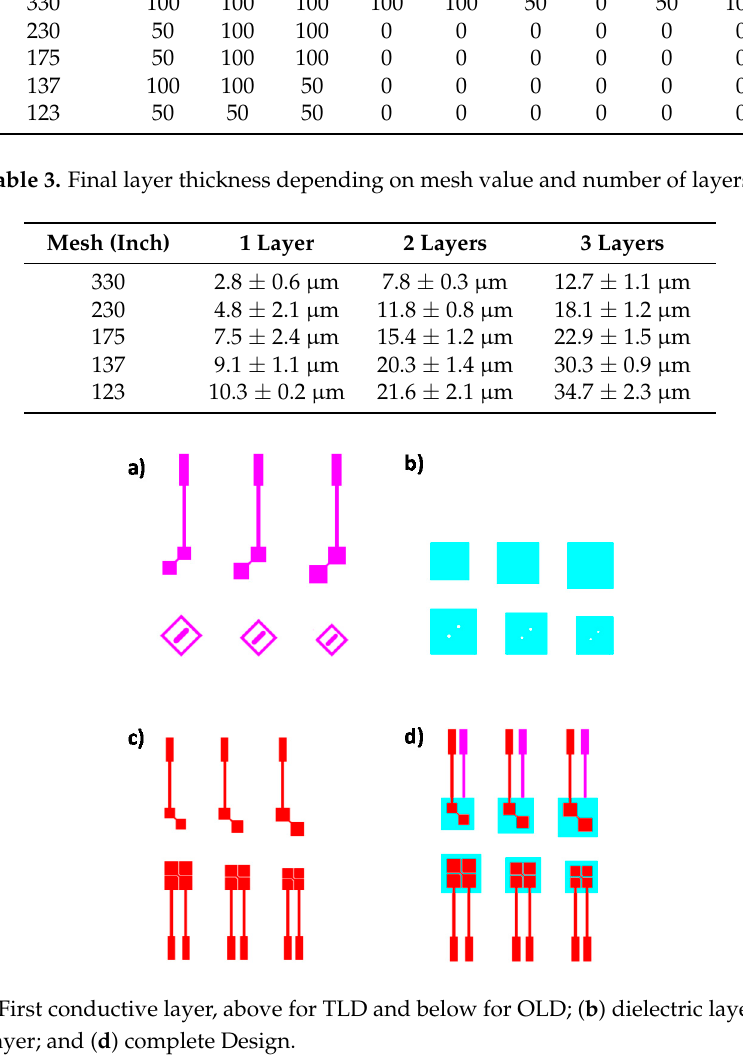
Figure 5. ( a ) First conductive layer, above for TLD and below for OLD; ( b ) dielectric layer; ( c ) second conductive layer; and ( d ) complete Design. conductive layer; and ( d ) complete